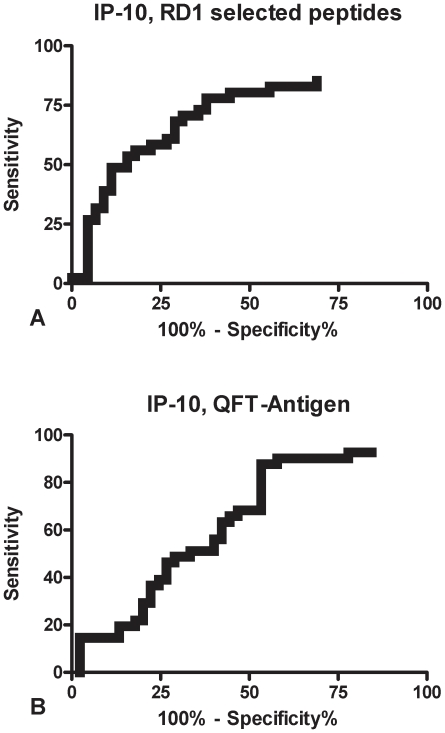
IP-10 release in response to RD1 selected peptides and TB antigen is associated with active TB.An ROC analysis was performed among the HIV-uninfected individuals using the active TB patients and the community controls as comparator groups. A) IP-10 release in response to the RD1 selected peptides is significantly associated with active TB. B) IP-10 release in response to the QFT-antigen is associated with active TB.